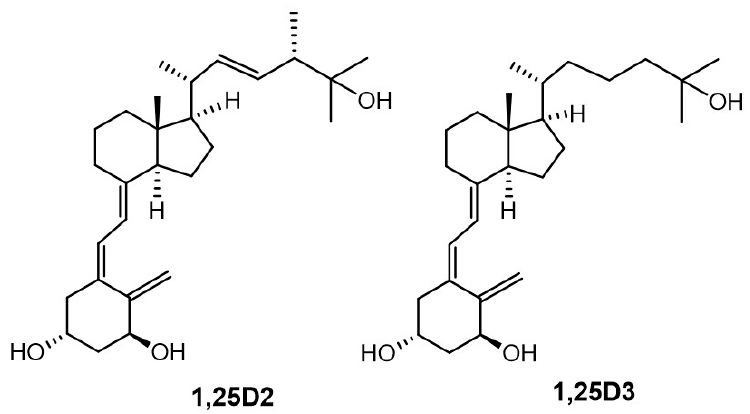
Figure 1. The structures of 1 α ,25-dihydroxyvitamin D 3 (1,25D3) and 1 α ,25-dihydroxyvitamin D 2 (1,25D2).